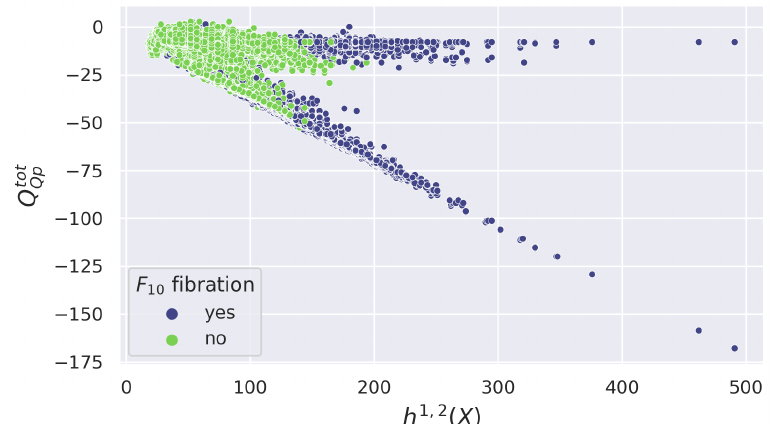
Figure 5 . Total D3-charge contributions from O-planes for orientifold models with colours indicating the presence of an underlying F = P [2 , 3 , 1] 10